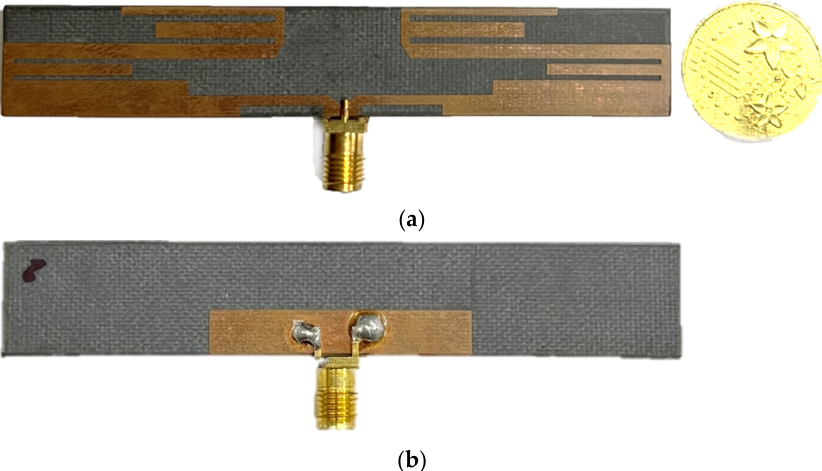
Figure 2. Prototype of realized monopole antenna array. ( a ) Front view and ( b ) back view.